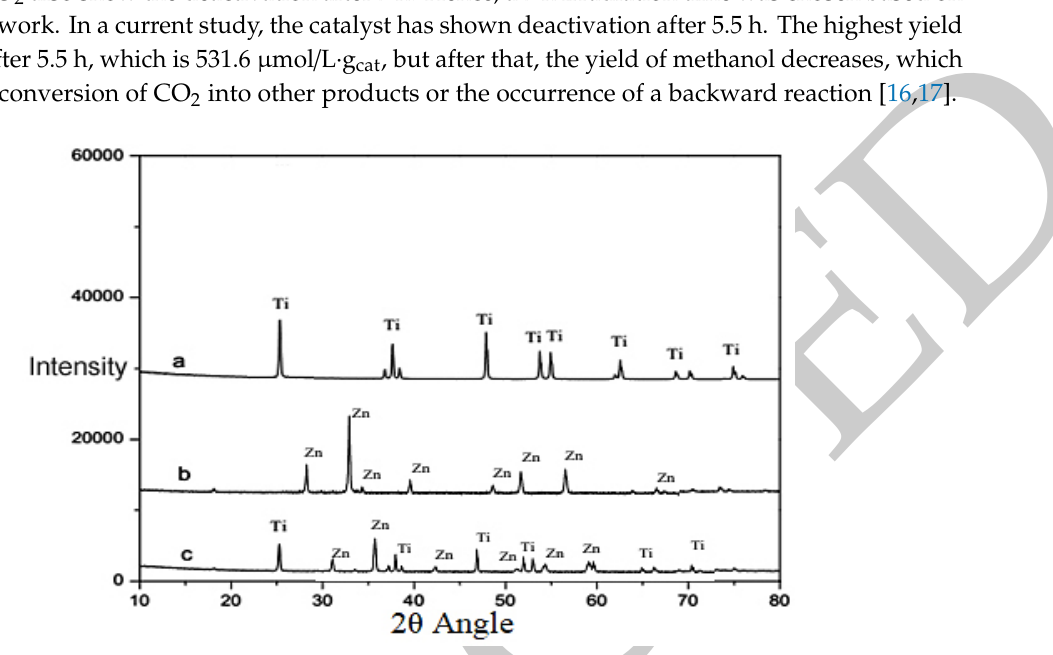
Figure 4. XRD spectra ( a ) TiO 2 , ( b ) ZnFe I 2 O 4 , and ( c ) ZnFe I 2 O 4 :TiO 2 (1:1).